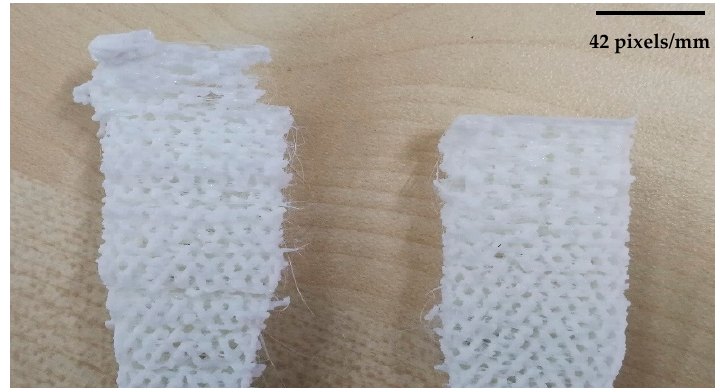
Figure 11. Defect in 75° flat samples.